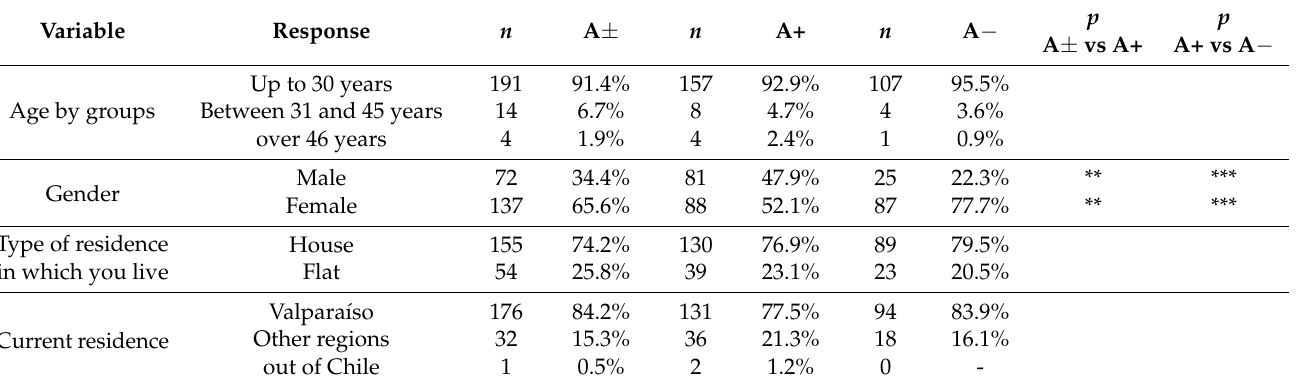
Table 4. Groups according to socio-demographic